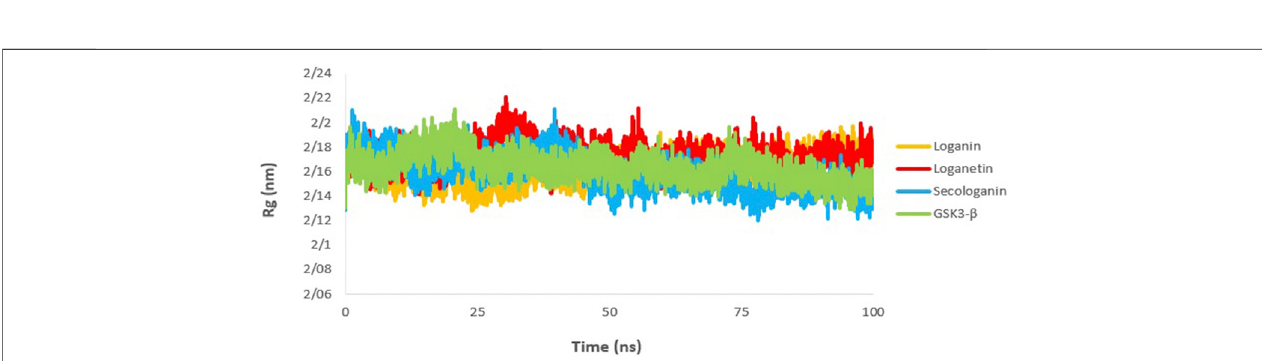
FIGURE 10 | Rg analysis GSK3- β protein (green), loganin-GSK3- β complex (yellow), loganetin-GSK3- β complex (blue), and secologanin-GSK3- β complex (red).